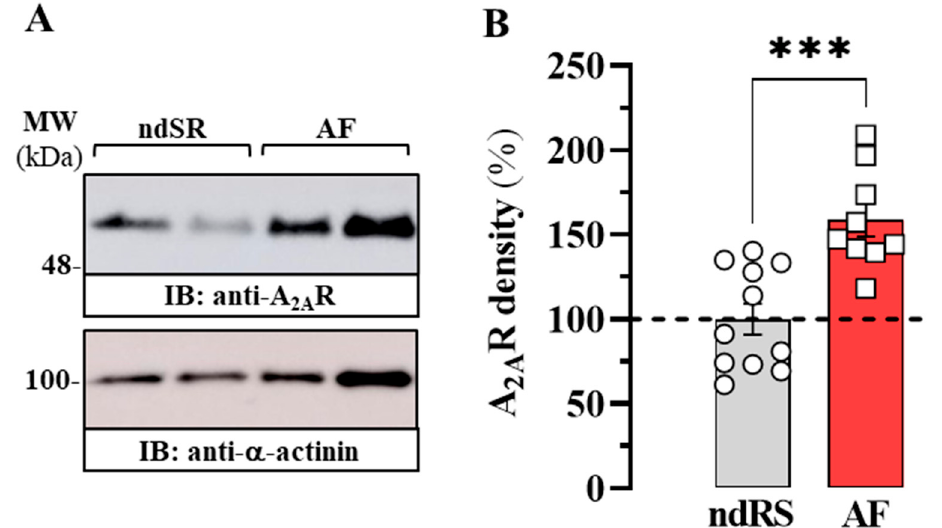
Figure 5. Expression A 2A R in human heart atria of AF patients. ( A ) Representative immunoblot showing the expression of the A 2A receptor in the right atria of non-dilated sinus rhythm (ndSR, circles) and atrial fibrillation (AF, squeres) patients. Membrane extracts from human atrium were analysed by SDS-PAGE (10 µ g of protein/lane) and immunoblotted using rabbit anti-A 1 R, mouse anti-A 2A R and rabbit anti- α -actinin antibodies (see Material and Methods). ( B ) Relative quantification of A 2A R density. The immunoblot protein bands corresponding to A 2A R and α -actinin from ndSR ( n = 11) and AF ( n = 9) subjects were quantified by densitometric scanning. Values were normalized to the respective amount of α -actinin in each lane to correct for protein loading. The results are shown as percentage of the relative density of A 2A R in ndRS (dashed lane) and expressed as mean ± SEM. *** p < 0.001, Student’s t